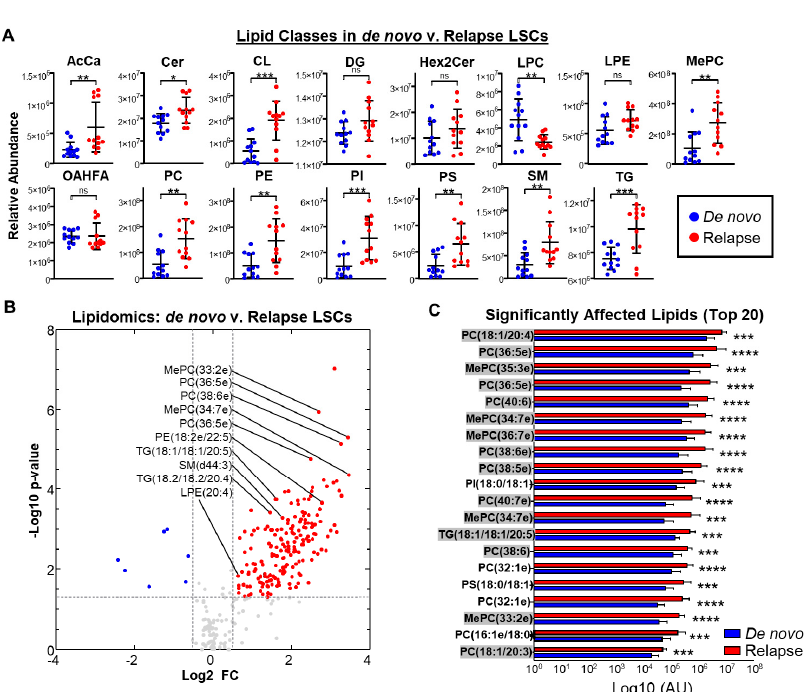
Figure 2. Relapsed LSCs display an aberrant lipid metabolism. Lipidomics were performed using LSCs from de novo patients 1, 2, and 3 and relapsed patients 1, 2, and 3. ( A ) Total levels of lipids within individual lipid classes between de novo and relapsed AML LSCs. ( B ) Volcano plot displaying lipids increased in de novo and relapsed AML LSCs. ( C ) Top 20 significantly affected lipids in de novo and relapsed AML LSCs. Those containing at least 2 unsaturations are highlighted in gray. * p ≤ 0.05, ** p ≤ 0.01, *** p ≤ 0.001, **** p ≤ 0.0001.